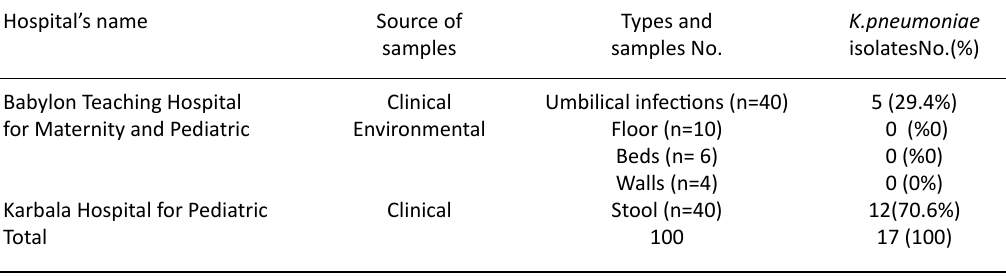
table 1. Prevalence of 17 K.pneumoniae isolates obtained from various samples Hospital’s name